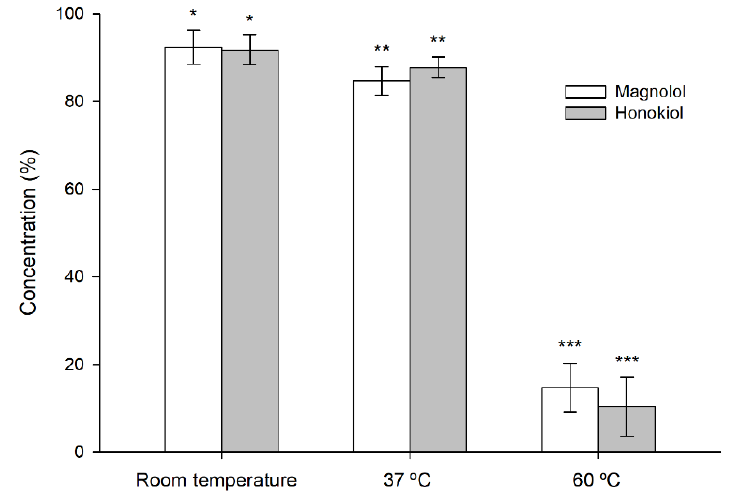
Figure 6. Stability of magnolol and honokiol after 24 h at room temperature, 37 ◦ C, and 60 ◦ C, under oxidizing conditions (3% hydrogen peroxide). Data are expressed as the percentage of the initial concentration. * p < 0.05, ** p < 0.01, *** p < 0.001.